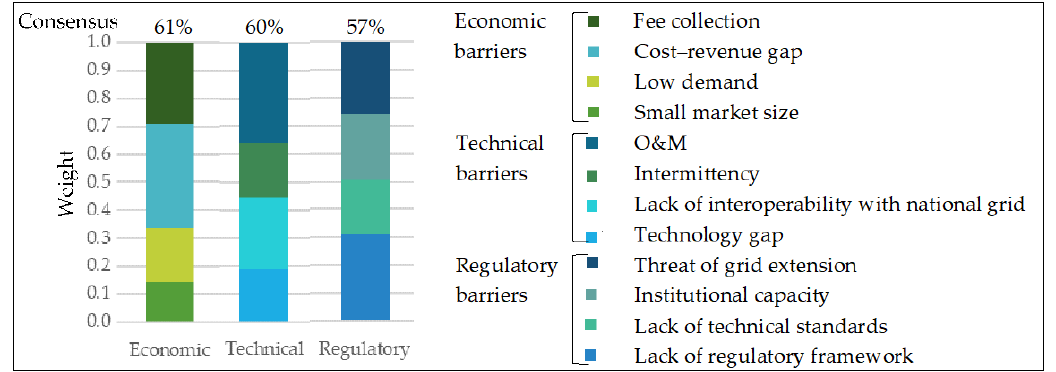
Figure 2. Weights of factors of economic, technical and regulatory barriers.